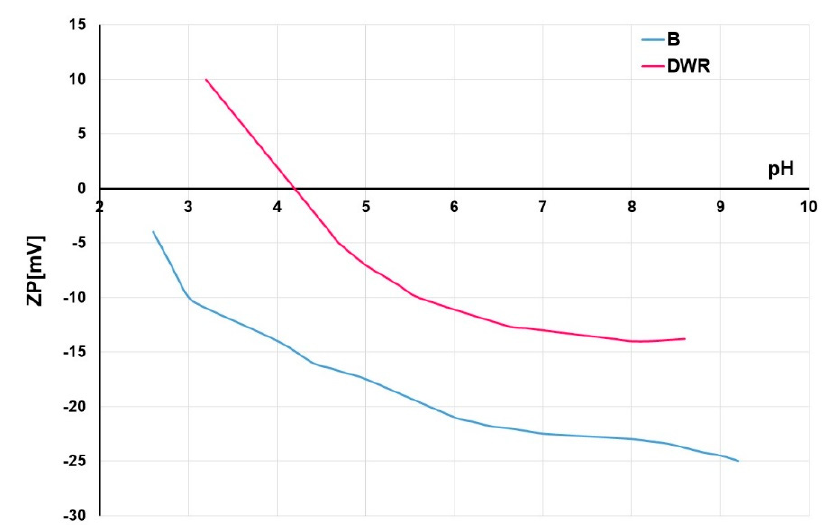
Figure 1. Zeta potential (ZP) vs. 0.001 mol/L KCl of cotton fabrics: standard unmodified (B) and cationized with Rewin DWR (DWR).